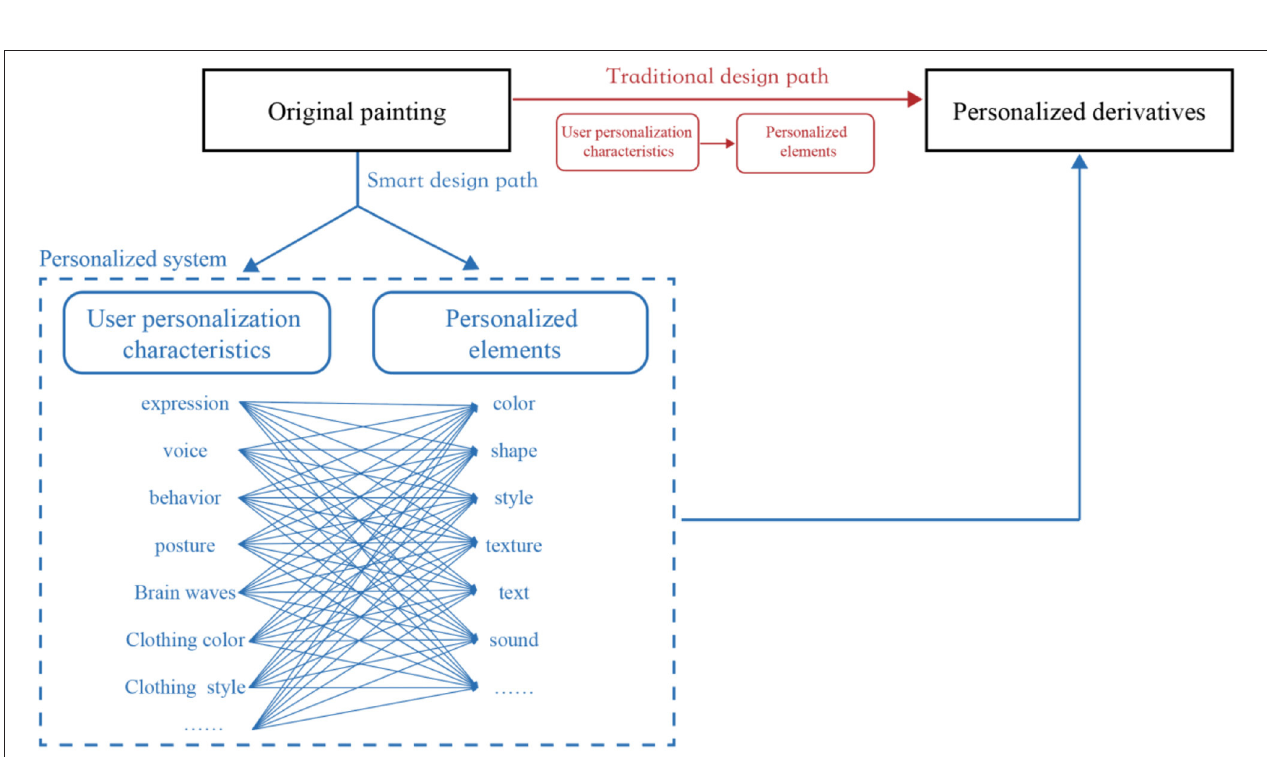
FIGURE 13 | The relationship between user emotional characteristics and individual elements.